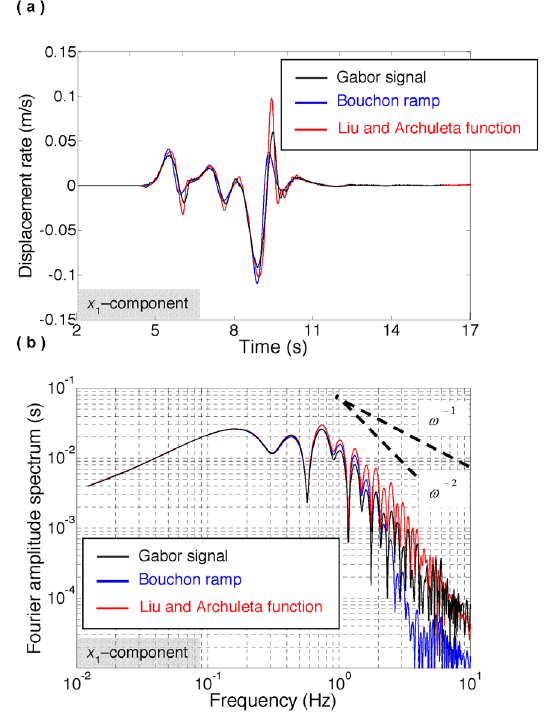
Figure 6. (a) The same as Figure 2a, but now for a free surface re- ceiver located at a distance of 25 km from the epicenter and 10 km from the fault trace. (b) Corresponding FAS.